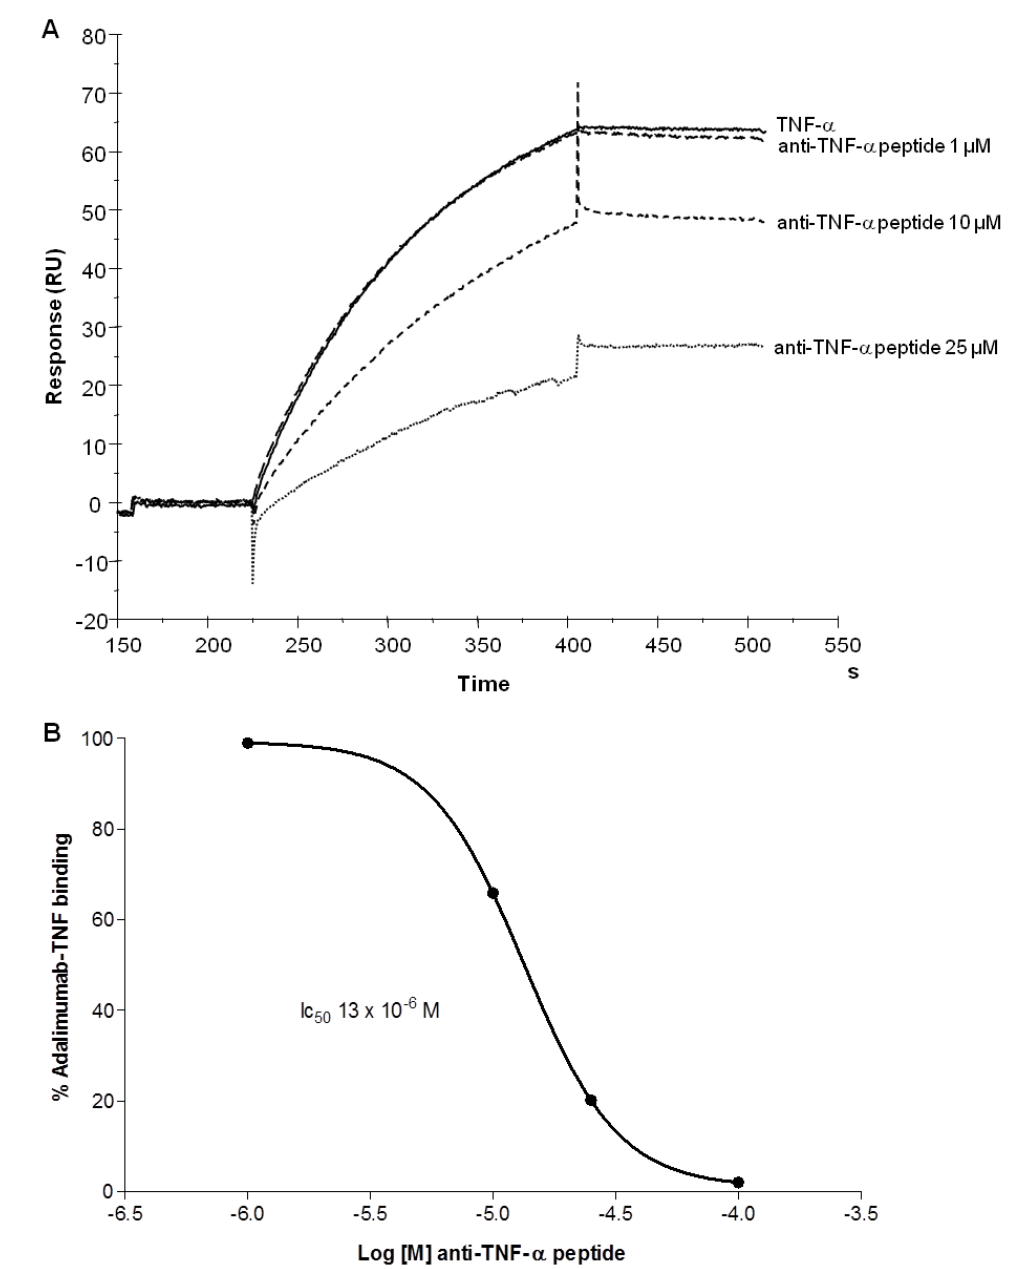
Figure 3. Inhibition of hTNF- α binding to adalimumab by branched anti-TNF- α peptide in SPR. A, adalimumab was captured via Protein A on a CM5 sensor chip as described in the Experimental Section. hTNF- α was flowed in the presence of different concentrations (1, 10 and 25 µM) of branched anti-TNF peptide. B, Curve of binding inhibition of hTNF- α binding to adalimumab derived by experiment in A. y axis indicates the percentage of binding between adalimumab and hTNF- α ; x axis represents the concentration of tetra- branched anti-TNF peptide. The IC is 50